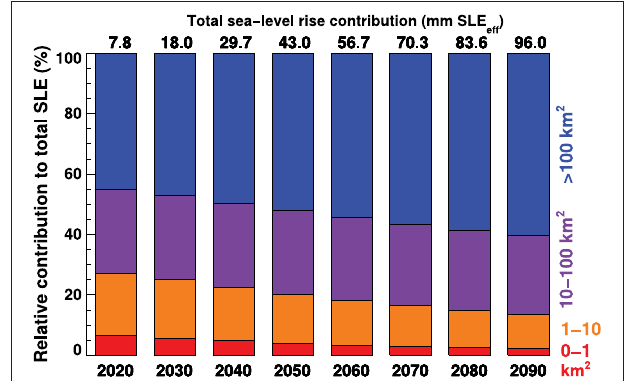
FIGURE 8 | Relative sea-level rise contribution (SLE eff ) of individual glacier size classes averaged over 10-year periods. All results refer to the multi-model mean of